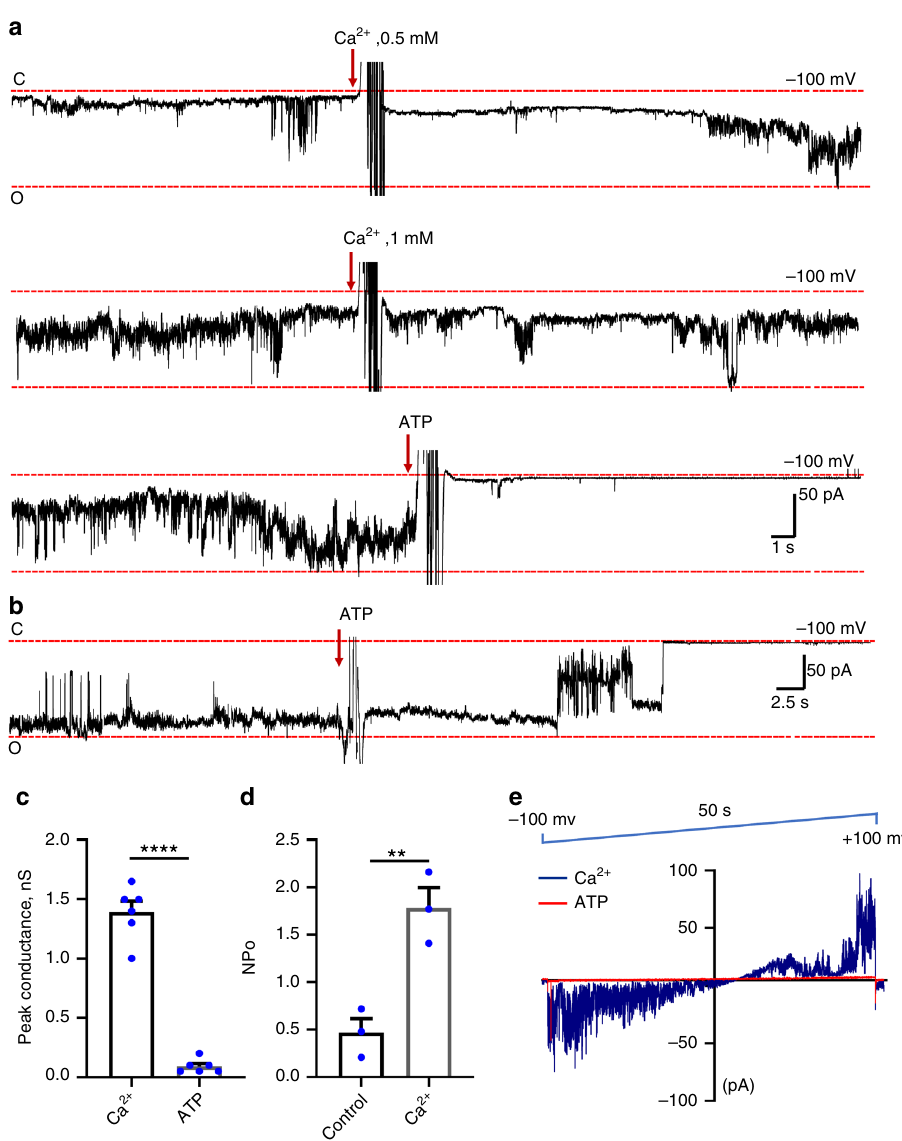
Fig. 4 ATP synthase forms a channel sensitive to Ca 2 + . a A single continuous recording of ATP synthase reconstituted liposomes in the presence of increasing concentrations of Ca 2 + . Ca 2 + was added twice during the recording, yielding fi nal concentrations of 500 µ M and 1 mM. ATP still inhibits the channel activity in the presence of Ca 2 + . The current trace is representative of 6 recordings. b A single continuous recording of ATP synthase channel in the presence of 2 mM Ca 2 + . ATP synthase reconstituted liposomes were pre-exposed to 2 mM Ca 2 + before forming a patch. The current trace is representative of four recordings. c Group data for the peak conductance of ATP synthase channel activity in the presence of Ca 2 + with and without 1 mM ATP, n = 6, **** P < 0.0001, paired t test was used. d Group data for the open probability of channels (NPo) in response to Ca 2 + , n = 3, ** P < 0.0028, paired t test was used. Both subconductance and peak conductance levels were included in NPo measurements. e Current-voltage relationship of ATP synthase channel activity in the presence of Ca 2 + with and without 1 mM ATP. n = 6, **** P < 0.0001, error bars refer to SEM. The source data underlying ( c and d ) are provided as a Source Data fi